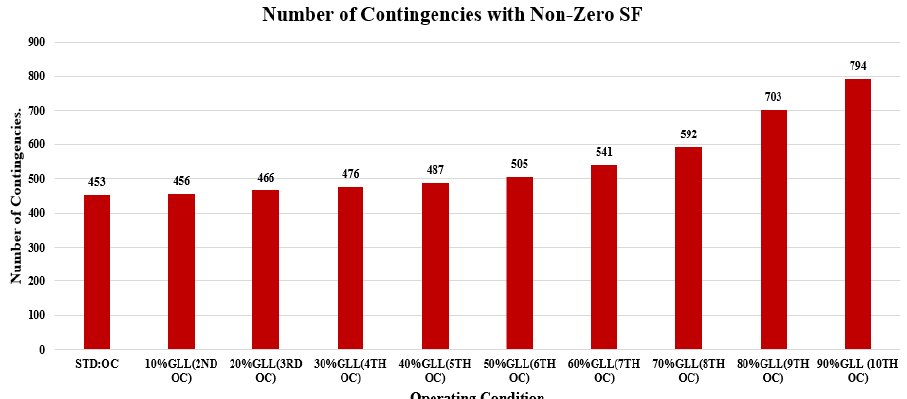
Figure 8. Severity factor in terms of number of non ‐ convergence contingencies under different operating conditions.